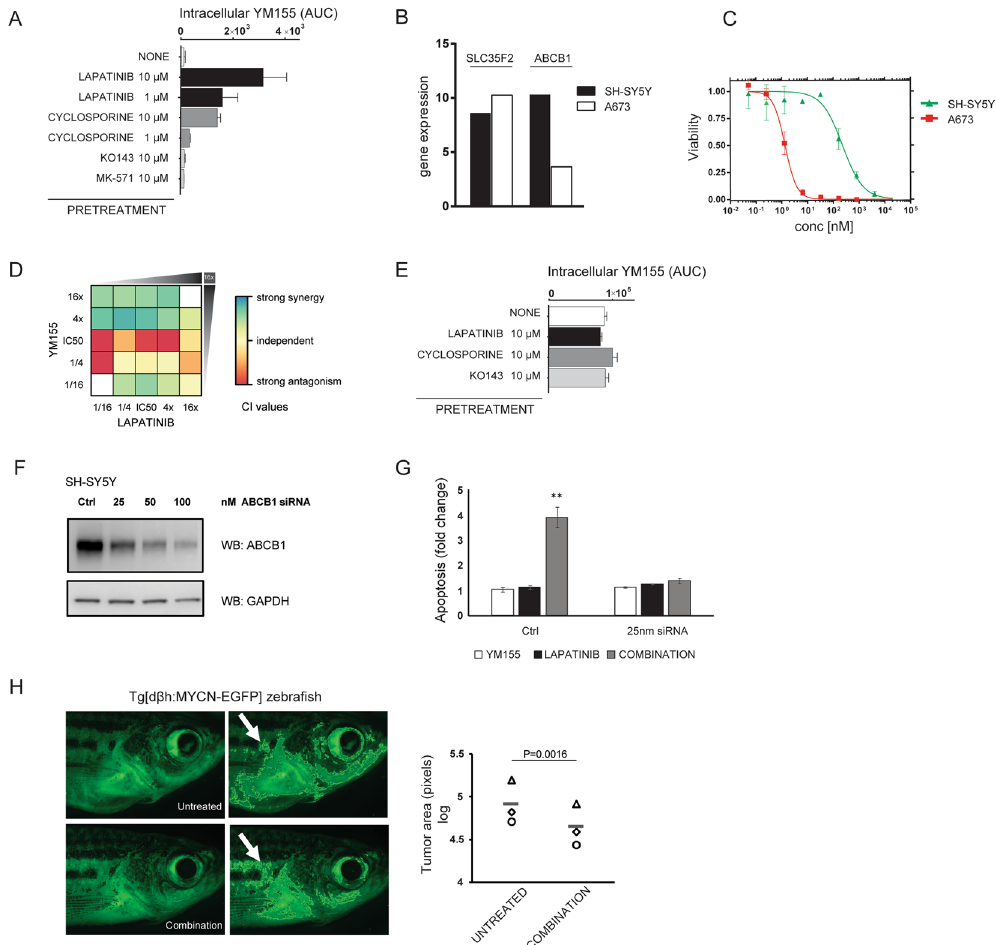
Figure 2. Synergistic effect is a consequence of a blocked efflux of YM155 by lapatinib in vitro . The anti- tumor effect of the combination is confirmed in an in vivo model. ( A ) Multiple-reaction monitoring assay in the SH-SY5Y neuroblastoma cells. Lapatinib inhibits the ABCB1 transporter and allows higher intracellular concentration of YM155. Area under the curve (AUC) corresponds to intracellular YM155 levels. Cyclosporine, MK-571 and KO143 are inhibitors of ABCB1, ABCC1 and ABCG2 transporters, (respectively). Data are the mean ± s.d. of triplicates. ( B ) Comparison of mRNA expression profiles of SLC35F2 and ABCB1 available in CCLE 32 between SH-SY5Y and A673 cells. ( C ) Dose response curves of the effects of YM155 on the viability of SH-SY5Y (green) and A673 cells (red). ( D ) Heatmap of CI values in the combination matrix of YM155 and lapatinib in A673 cells. Data represent the mean of triplicates. ( E ) Multiple-reaction monitoring assay in A673 cells. Area under the curve (AUC) corresponds to intracellular YM155 levels. Cyclosporine and KO143 are inhibitors of ABCB1 and ABCG2 transporters, (respectively). Data are the mean ± s.d. of triplicates. ( F ) Efficiency of ABCB1 knock down after 24 hours. ( G ) Combined effect of ABCB1 knockdown and YM155 and/ or lapatinib treatment on apoptosis of SH-SY5Y cells. Apoptosis was measured in SH-SY5Y cells which were transfected with control siRNA or siRNA against ABCB1 (25 nM); and treated with DMSO, 1 μ M lapatinib and/ or 15 nM YM155 for 48 hours. Percentages of cell death were used to calculate the fold changes in apoptosis of siRNA transfected and drug treated cells compared to untreated siRNA transfected cells. (Mean ± SEM, n = 3, ** P < 0.01, ANOVA). ( H ) Analysis of neuroblastoma growth in Tg[d β h:MYCN-EGFP] zebrafish, expressing MYCN-EGFP under the control of dopamine- β -hydroxylase promoter. Fish were treated with lapatinib and YM155 (2 µ M and 6.5 nM, respectively) for 7 days. Zebrafish were imaged before and after treatment with the same settings. The fluorescent area behind gills corresponding to tumors (white arrow) were measured by using ImageJ (representative images of three independent experiments, n = 3). A quantitation of the results is shown in the graph, where each symbol represents a fish (P = 0.0016, paired t